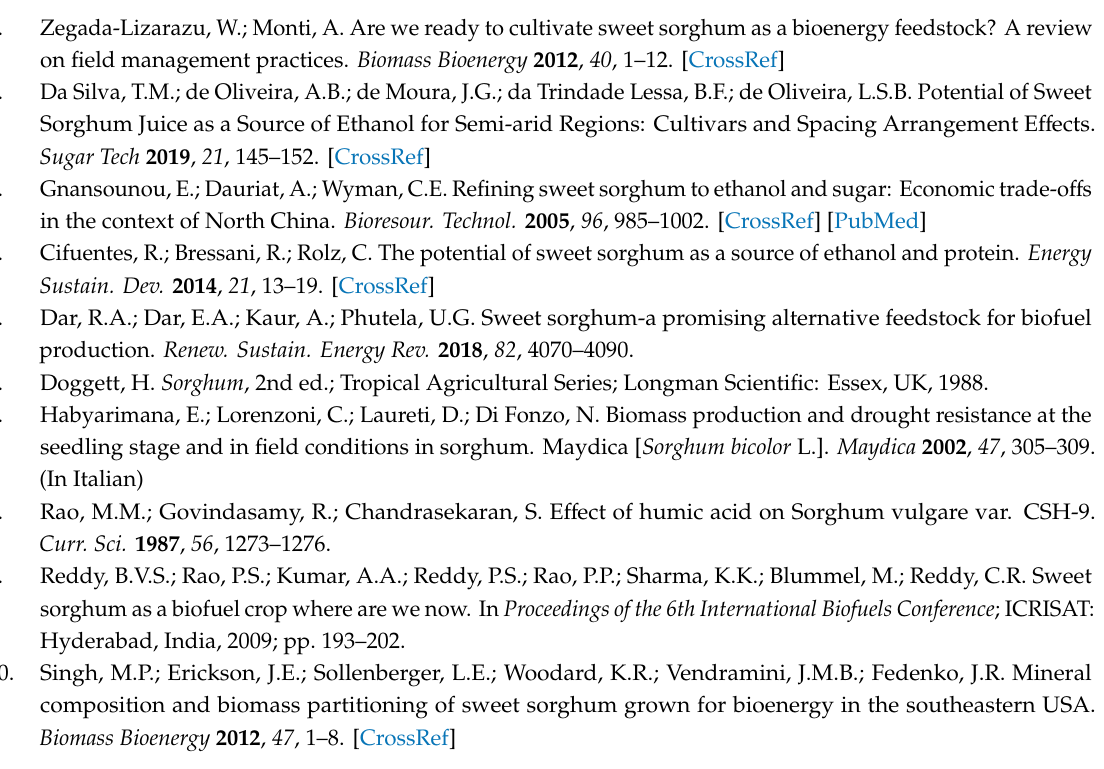
Table S1. Probability values ( p > 0.05) determined by variance analysis;